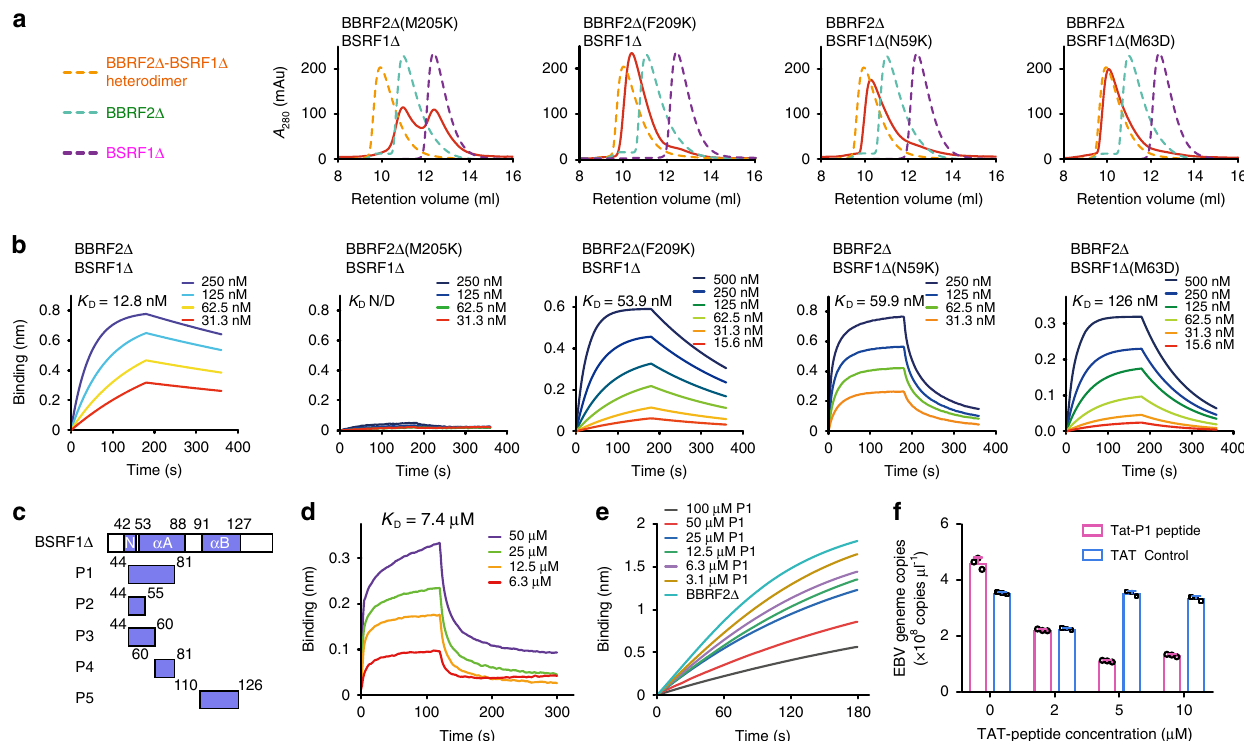
Fig. 4 Characterization of the BBRF2-BSRF1 heterodimeric interface. a SEC analysis of BBRF2 Δ -BSRF1 Δ interface mutants (Superdex 75). mAU milli- absorption units. The elution peaks are shown as dashed lines of BBRF2 Δ -BSRF1 Δ heterodimer (orange), BBRF2 Δ monomer (green), BSRF1 Δ monomer (purple) are overlaid with each sample (red) as references. b The binding af fi nity of BBRF2 Δ (wild-type or mutant) with BSRF1 Δ (wild-type or mutant) measured by BLI. BSRF1 Δ (wild-type or mutant) at different concentrations was exposed to 10 μ g ml − 1 His-tagged BBRF2 Δ (wild-type or mutant). Source data are provided as a Source Data fi le. c Schematic showing the designation of the fi ve BSRF1 Δ -derived peptides. N denotes the N-loop. d Binding af fi nity of peptide 1 (P1) and BBRF2 Δ measured by BLI. P1 at different concentrations was exposed to 10 μ g ml − 1 His-tagged BBRF2 Δ . Source data are provided as a Source Data fi le. e P1 competes with BSRF1 Δ in binding to BBRF2 Δ . 200 nM BBRF2 Δ mixed with different concentrations of P1 was exposed to 10 μ g ml −